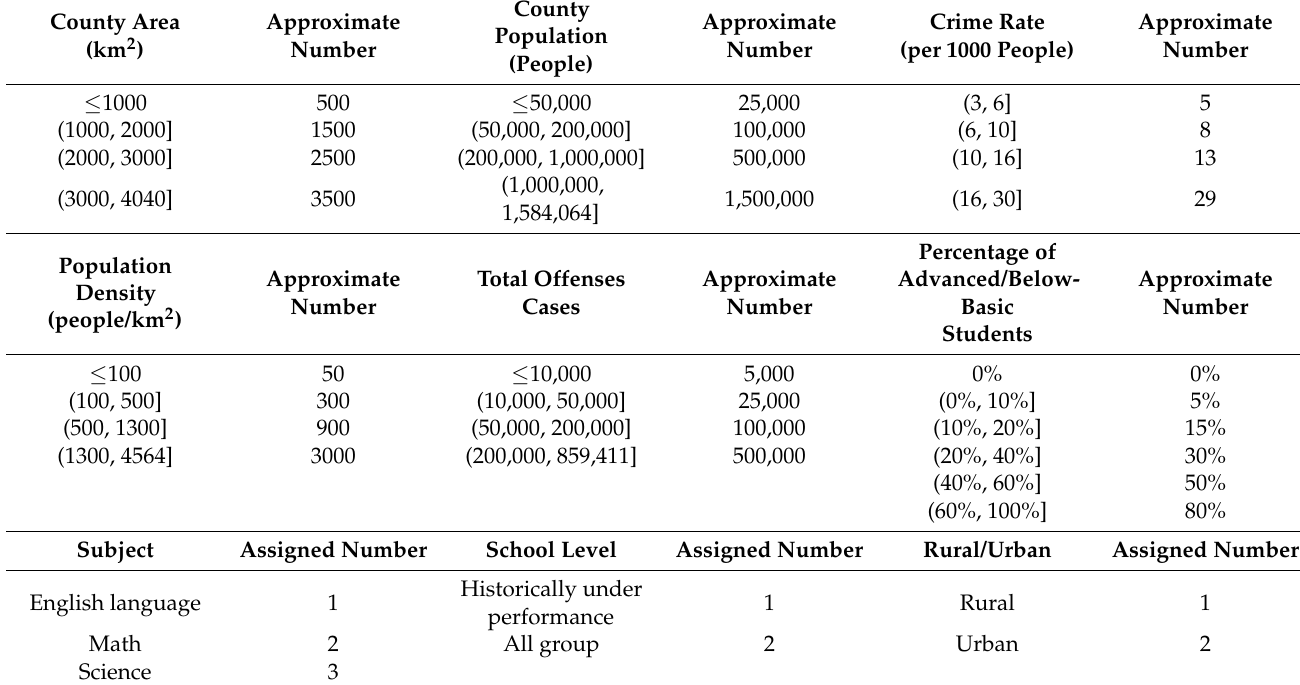
Table 2. Classification method for data